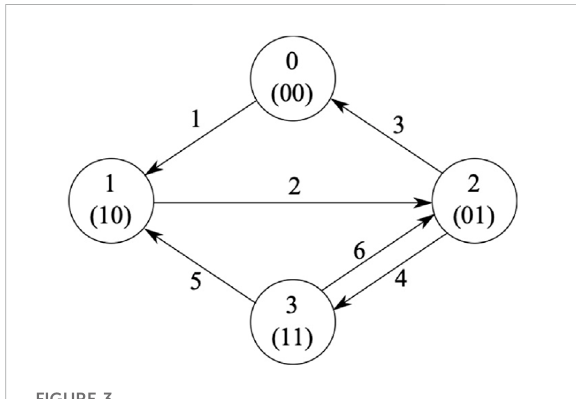
FIGURE 3 SHS Markov chain for two · /M/1/1 queues in